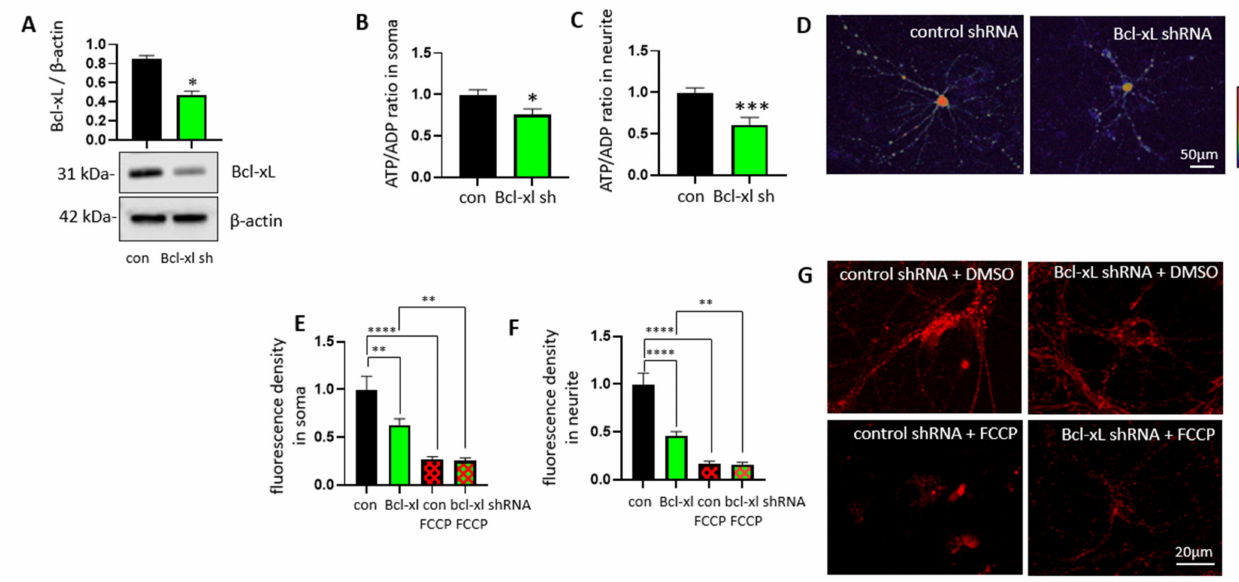
Figure 1. Bcl-xL depletion alters ATP/ADP ratio in primary hippocampal neurons. Primary rat hippocampal neurons were transduced with control shRNA or Bcl-xL shRNA. Immunoblotting ( A ) was performed to show depletion of the Bcl-xL protein levels in Bcl-xL shRNA transduced neurons ( n = 4, * p = 0.0286, Mann–Whitney test). ATP/ADP ratio ( B , C ) was measured using the GW1-PercevalHR sensor (F 488nm /F 405nm ). Bcl-xL depleted neurons showed lower ATP/ADP ratios in both the soma ( n = 20) and neurites ( n = 20). * p < 0.05, and *** p < 0.001, two-tailed Student’s t -test. Scale bar = 50 µ m. Pseu- docolour ratiometric micrographs ( D ) of neurons indicating the ATP/ADP ratio using the PercevalHR sensor. Red, higher ATP/ADP; Blue, lower ATP/ADP. Primary hippocampal neurons lacking Bcl-xL showed a significantly decreased TMRM signal ( E – G ), indicating a loss of mitochondrial inner membrane potential ( ∆ ψ ) ( n = 12). ** p < 0.01, and **** p < 0.0001, two-tailed Student’s t -test. Scale bar = 20 µ